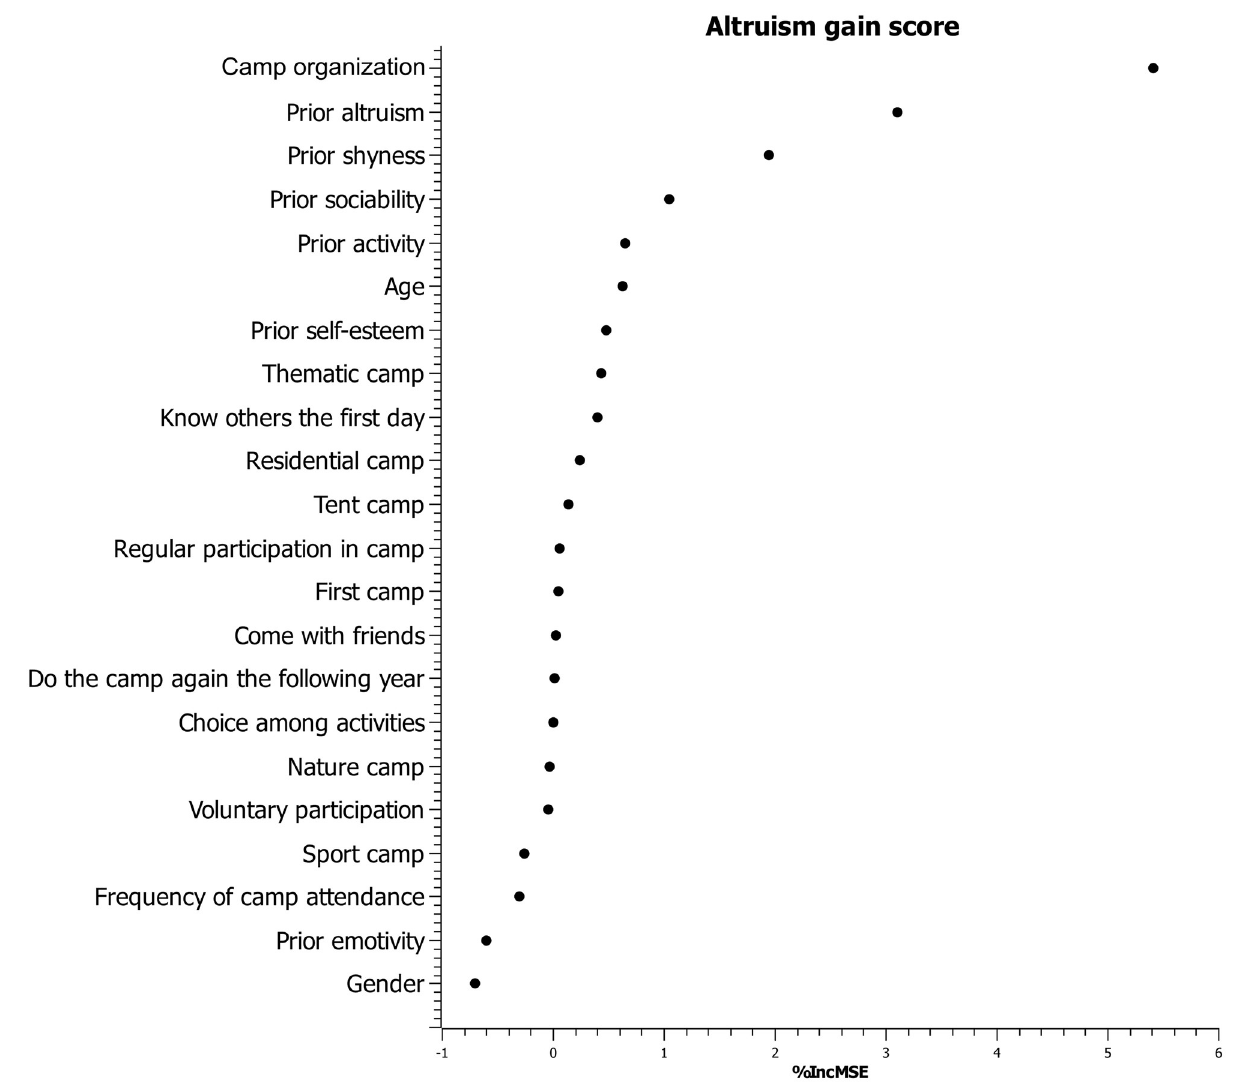
Fig 2. Variables importance plot for altruism gain score in the camp